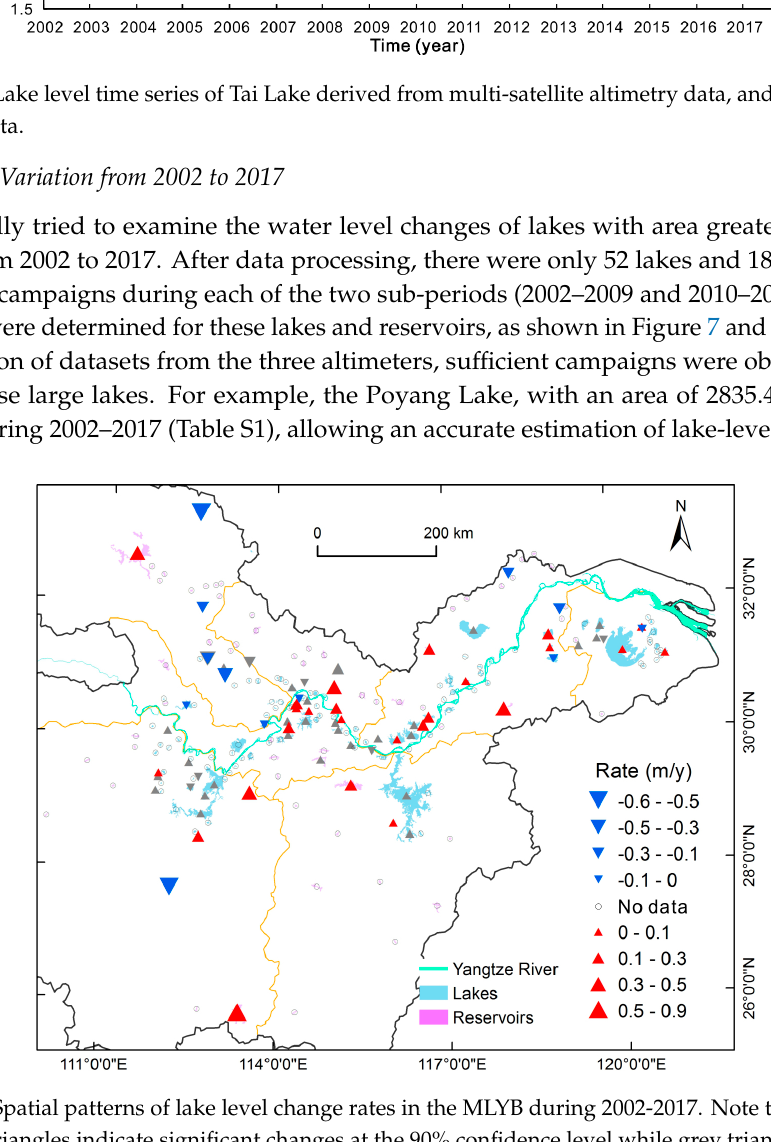
Figure 6. Lake level time series of Tai Lake derived from multi-satellite altimetry data, and from in-situ gauged data.